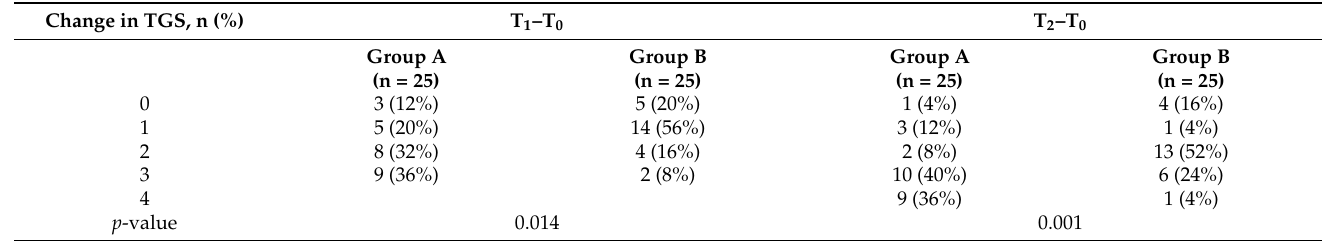
Table 3. Changes in the Tinetti Gait Scale (TGS).